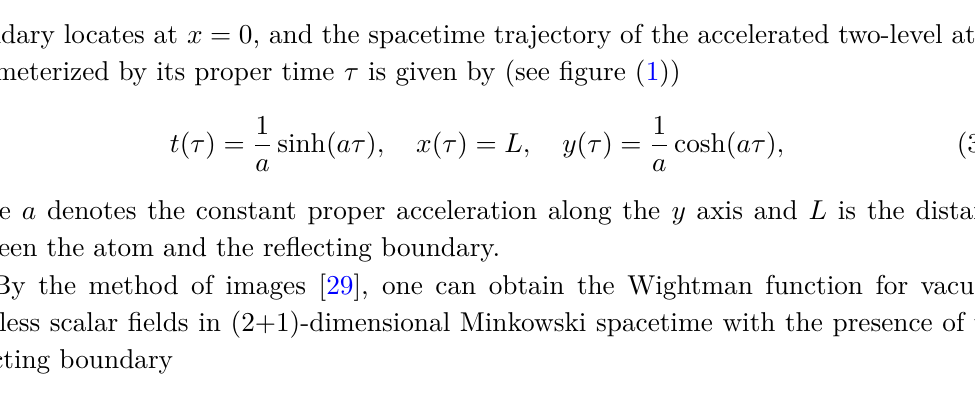
Figure 1 . An atom is uniformly accelerated along the y -axis with a proper distance L from a reflecting boundary in (2+1)-dimensional flat